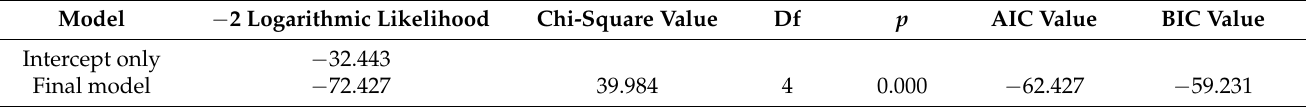
Table 3. Tobit regression model likelihood ratio